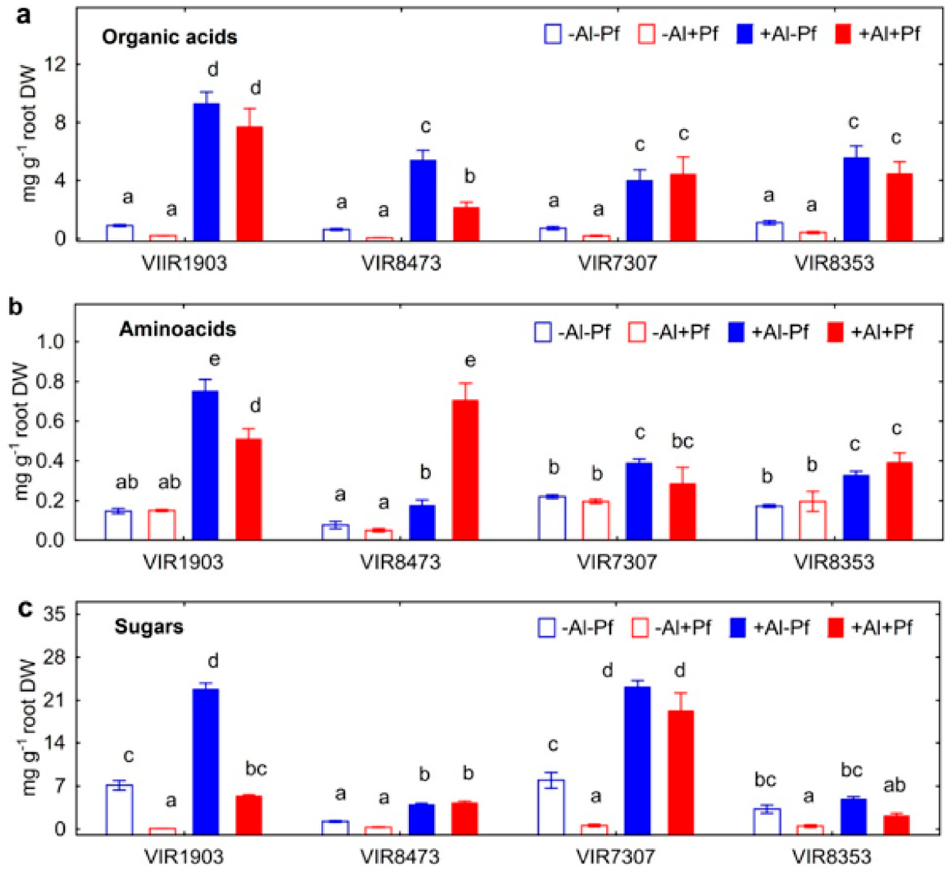
Figure 10. Effect of Pseudomonas fluorescens SPB2137 on total root exudation of organic acids ( a ), amino acids ( b ) and sugars ( c ) by pea genotypes VIR1903, VIR8473, VIR7307 and VIR8353 untreated and treated with 80 µM AlCl 3 . Treatments: − Al-Pf—Al-untreated and uninoculated control plants, − Al+Pf—Al-untreated and inoculated plants, +Al-Pf—Al-treated and uninoculated plants, +Al+Pf—Al-treated and inoculated plants. The data present the amount of exuded compounds of each category in sum for the period of plant cultivation divided by the root biomass. Vertical bars show standard errors. Different lowercase letters show significant differences between treatments (least significant difference test, p < 0.05, n = 3). DW stands for dry weight.